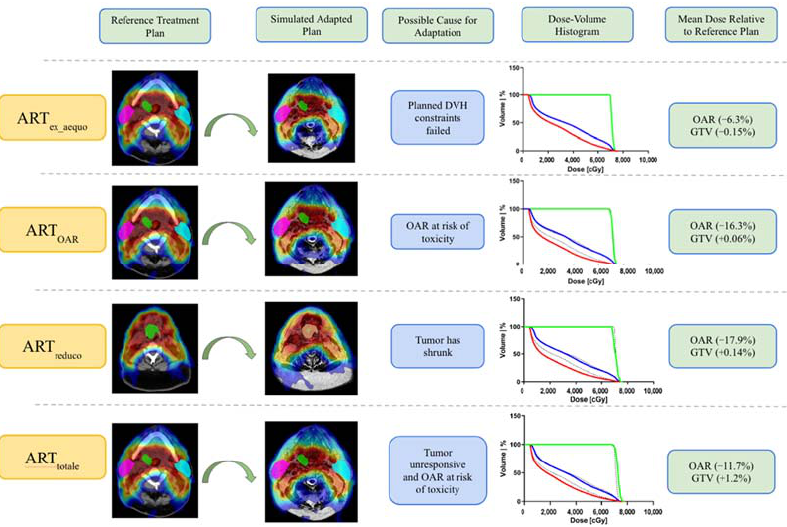
Figure 1. Demonstration of ART intents and relative dosimetric on OARs and tumor. This example shows the initial treatment plan on CT and simulated adapted plans on an MR-linac image for a patient with primary stage T3N2 human papilloma virus positive squamous cell carcinoma of the base of tongue prescribed 70 Gy in 33 fractions. In silico simulated adapted plans were generated with the various ART intents on the MR-linac image from fraction 22. Graphs show dose volume histograms for the gross target volume (GTV) (green), ipsilateral parotid gland (blue), and contralateral parotid gland (red) with solid lines for the adaptive plan and dotted lines for the reference plan. In the column showing the DVH parameters relative to the reference plan, mean dose was used for the parotid glands and D 95% for the PTV. For the ART Reduco plan, reduced GTV and PTVs were artificially created by applying a uniform reduction of 1cm in all directions for each